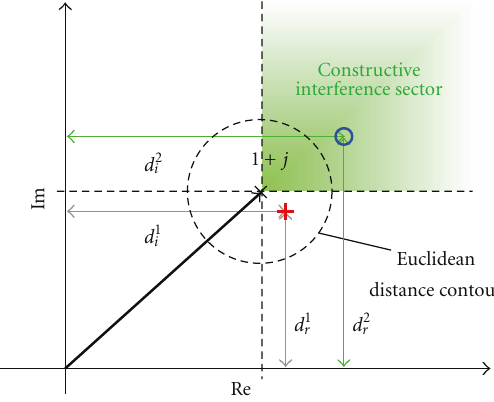
Figure 3: Euclidean distance versus projection criterion, QPSK x = 1 + j